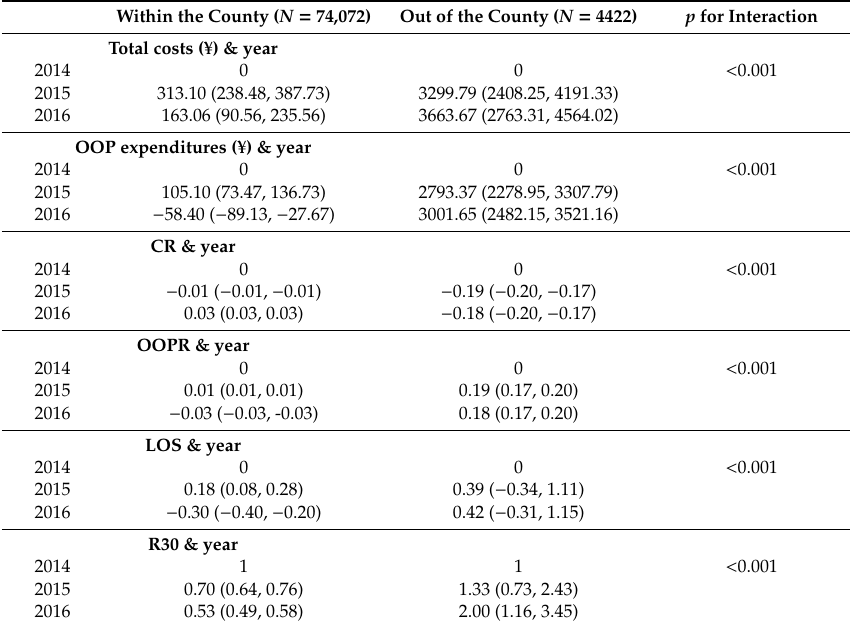
Table 3. Hierarchical regression results of cerebral infarction inpatients within and outside the county. Within the County ( N = 74,072) Out of the County ( N =